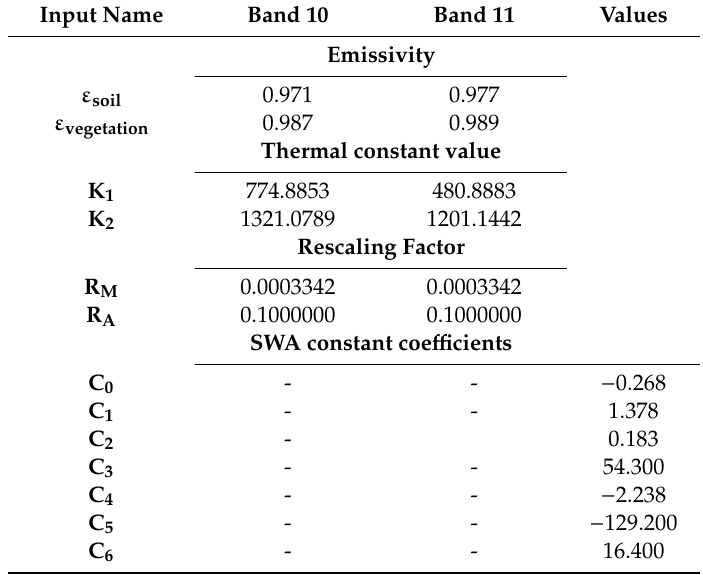
Table 1. Details of the data used to run the SWA on Landsat-8 images